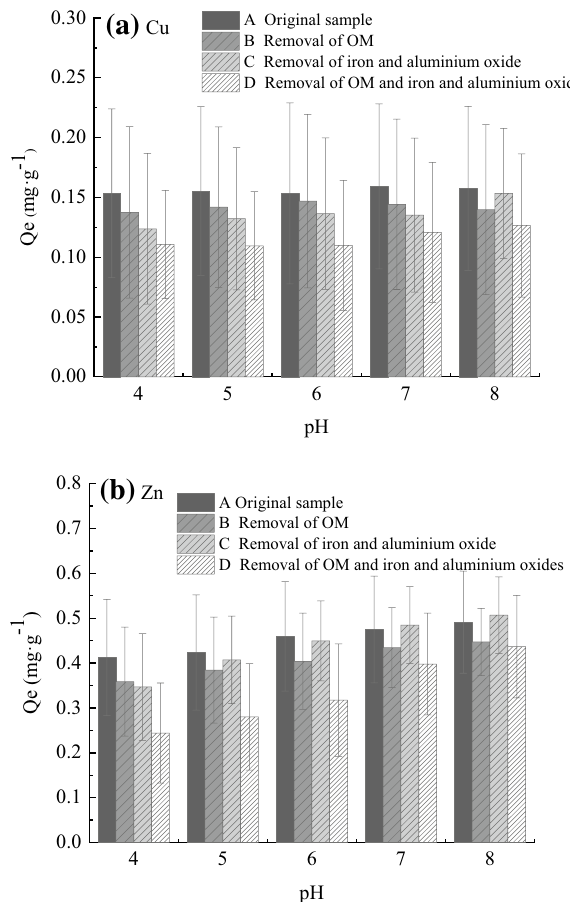
Figure 7. Relationship between adsorption capacity and pH. ( a ) Adsorption capacity for Cu of four groups of samples at different pH values; ( b ) Adsorption of Zn to four groups of samples at different pH